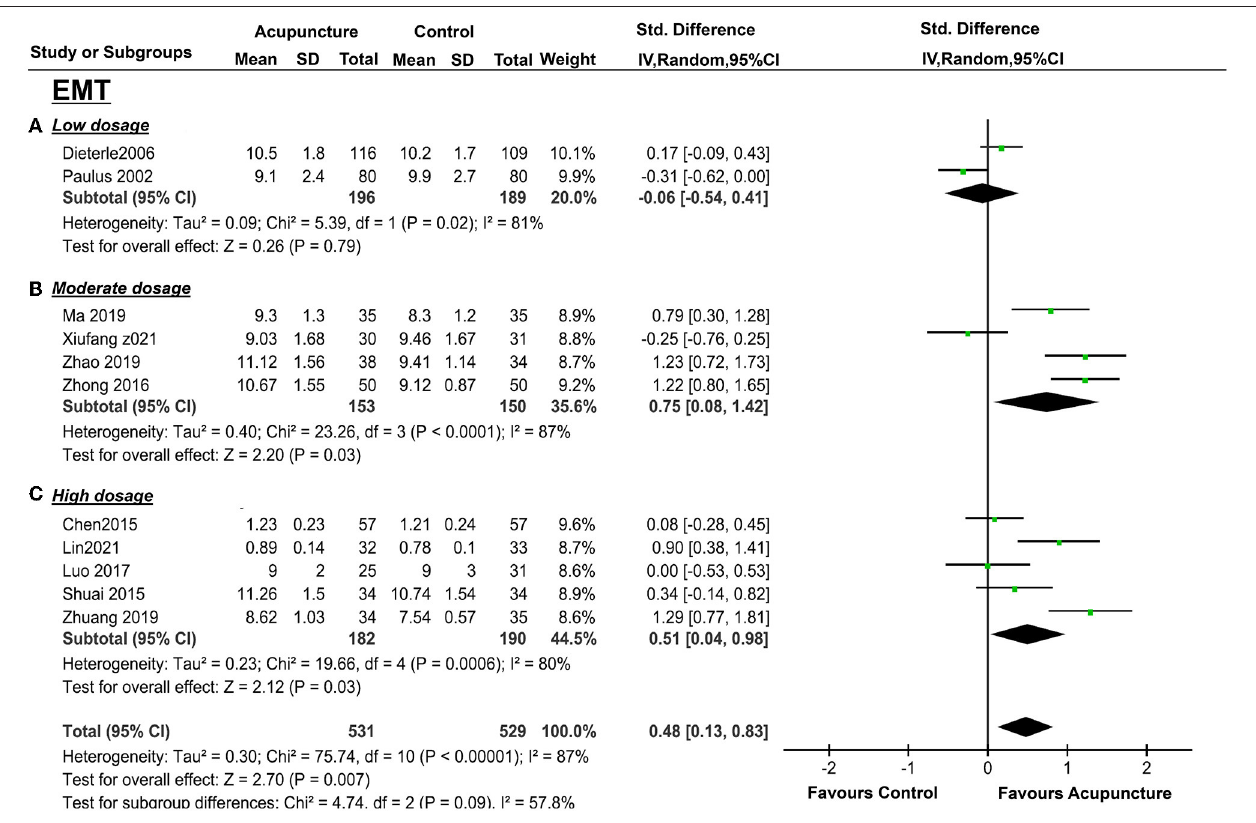
FIGURE 5 | Effects of acupuncture on EMT based on intervention of low dosage (A) , moderate dosage (B) , and high dosage (C) .